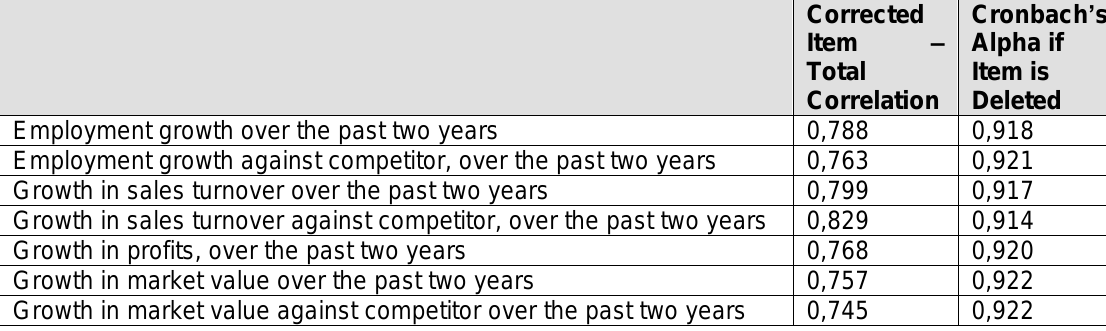
Table 4: Item statistics for SMME sustainability indicators